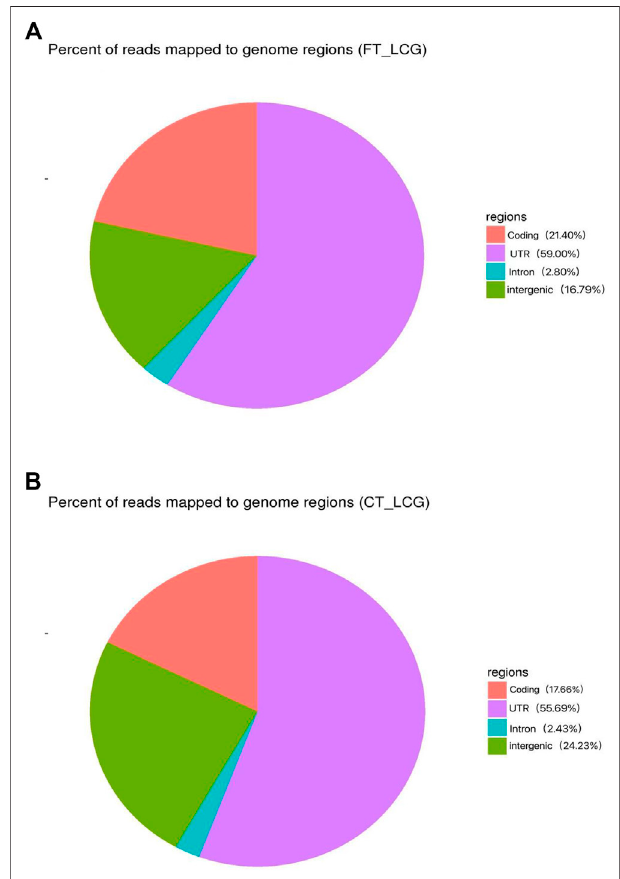
FIGURE 2 | Distribution of reads in different regions of the reference genome.Redindicatesthecodingarea.Purple indicates theUTRarea.Green indicates the intergenic area. Blue indicates the intron area. (A) Sample of fi ne LCG. (B) Sample of coarse